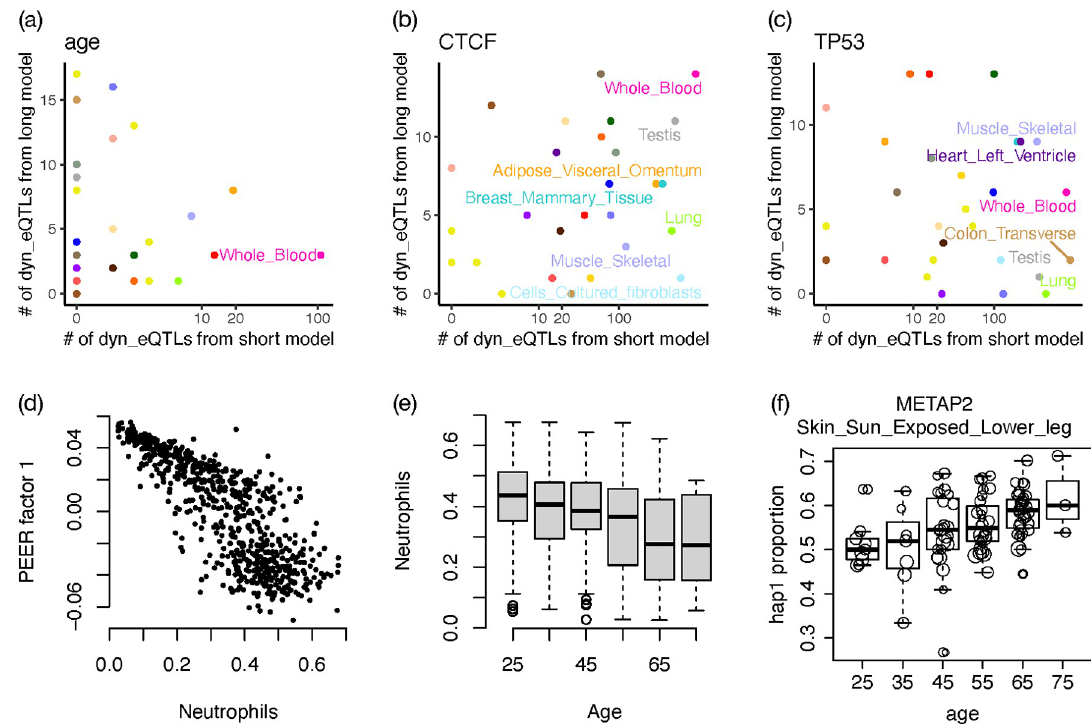
Fig 4. Dynamic eQTLs. (a)-(c) The number of dynamic eQTLs identified (q-value < 0.1) using short model (without any additional covariate) versus long model (with 7 additional covariates, top 5 PEER factors and top 2 genotype PCs). X-axis is in log10 scale. Each point is a tissue, and the color scheme is illustrated at the bottom of Fig 2. Tissues with a large number of dynamic eQTLs ( > 100 for age or CTCF and > 200 for TP53) using short model are labeled. (d) Association between the first PEER factor from GTEx study and the proportions of neutrophil in whole blood. (e) Association between neutrophil proportion in whole blood and age. (f) An example of dynamic eQTL (q < 0.1 in long model) whose eQTL effect size varies with respect to